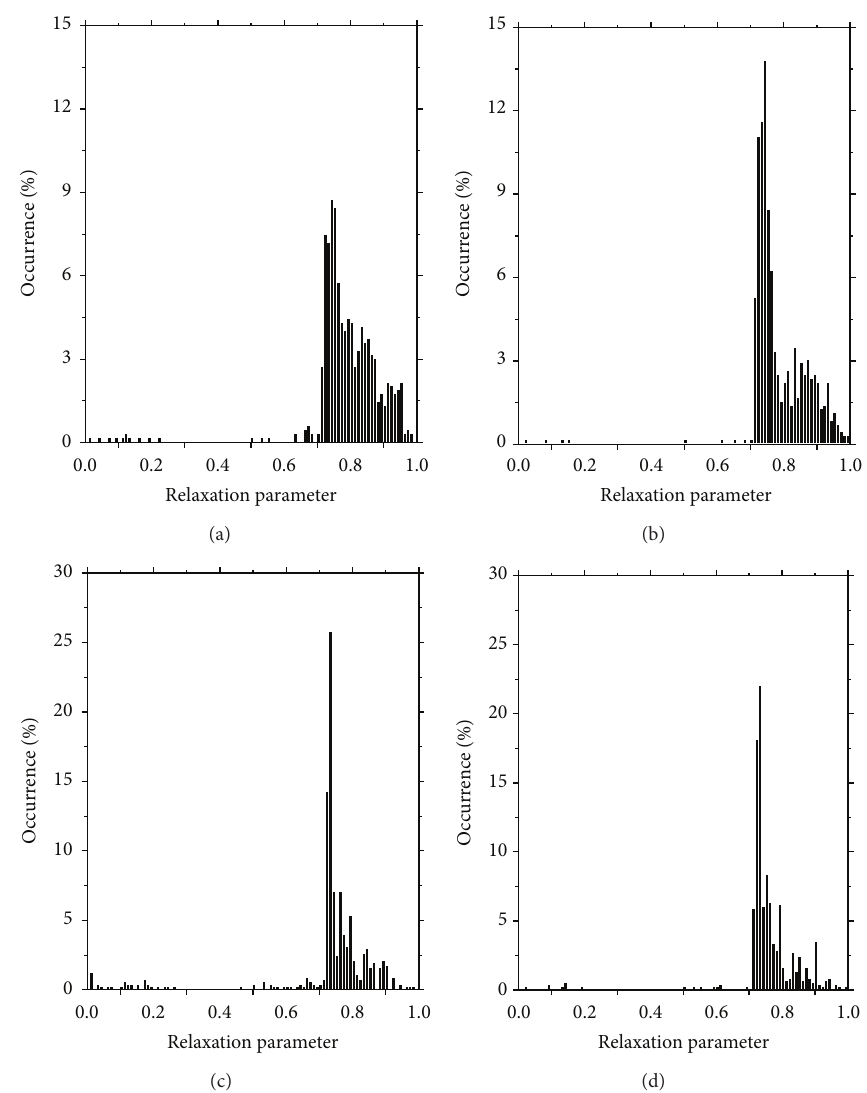
Figure 5: Percentage of occurrence of different relaxation parameter values during the analysis, considering 𝐼(𝑡) = 𝑡 and (a) case 1 and (b) case 2; 𝐼(𝑡) = 𝑡 2 and (c) case 1 and (d) case